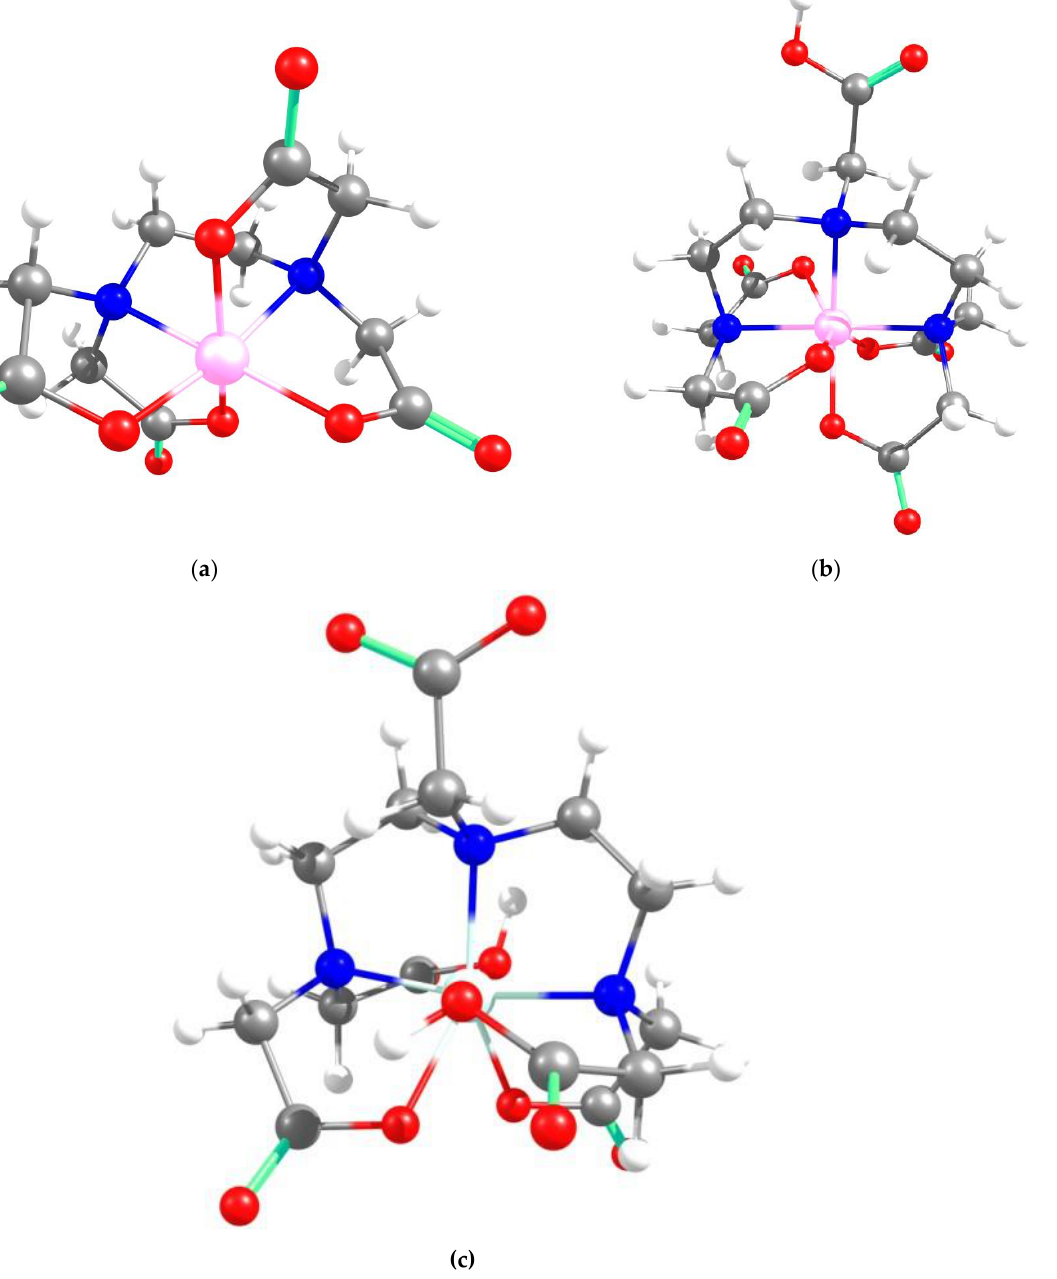
Figure 14. Proposals for the spatial representation of EDTA ( a ) and DTPA ( b ) structures investigated in coordination with transition metal ions. ( c ) The spatial structure for CuC14N3H19O10 with two dative bonds from two carboxyl groups.